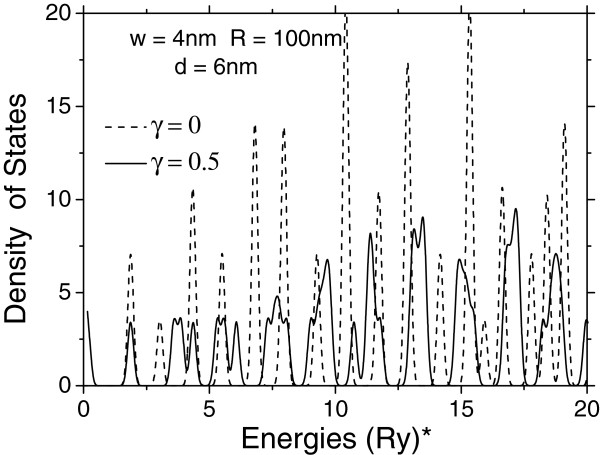
Density of states for two different values of the magnetic field. Corresponding to low-lying levels of the double-donor complex in vertically coupled QDs.